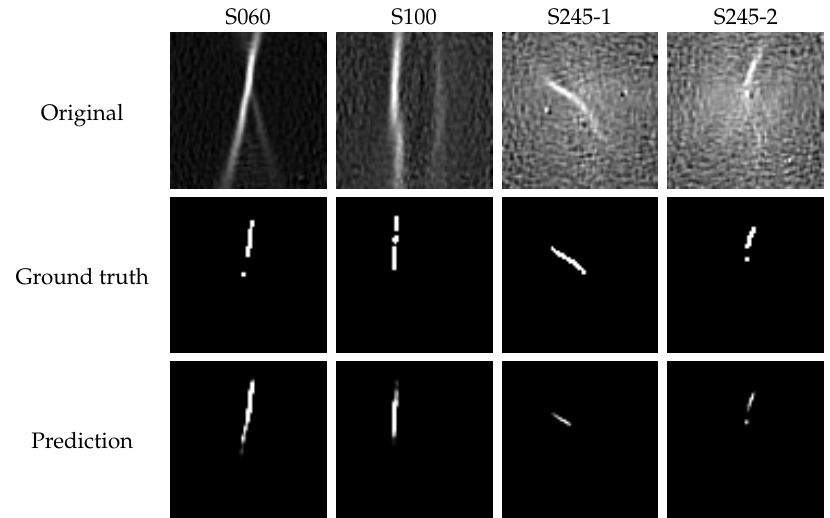
Figure 4. Difference strain images of AA6014 together with their ground truth annotations and predictions. Correct segmentation results are generated despite the presence of outliers in S245-1 and S245-2. In S245-2, an outlier is incorrectly included in the ground truth mask and predicted accordingly. The single pixel in the ground truth mask of S060 is a result of the mask generation process and not really an outlier, as it occurs within the necking structure. The same accounts for the discontinuity in